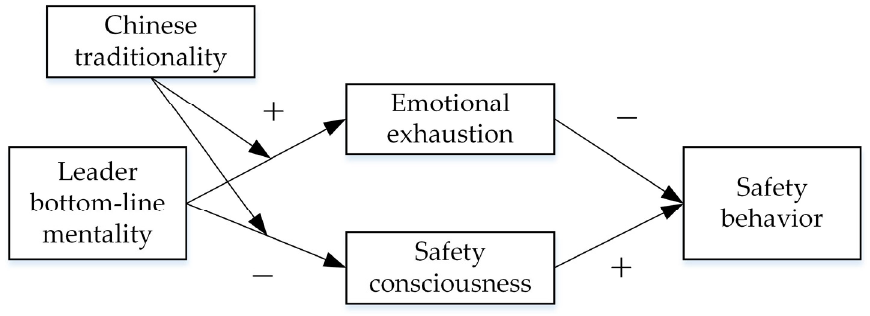
Figure 1. Theoretical